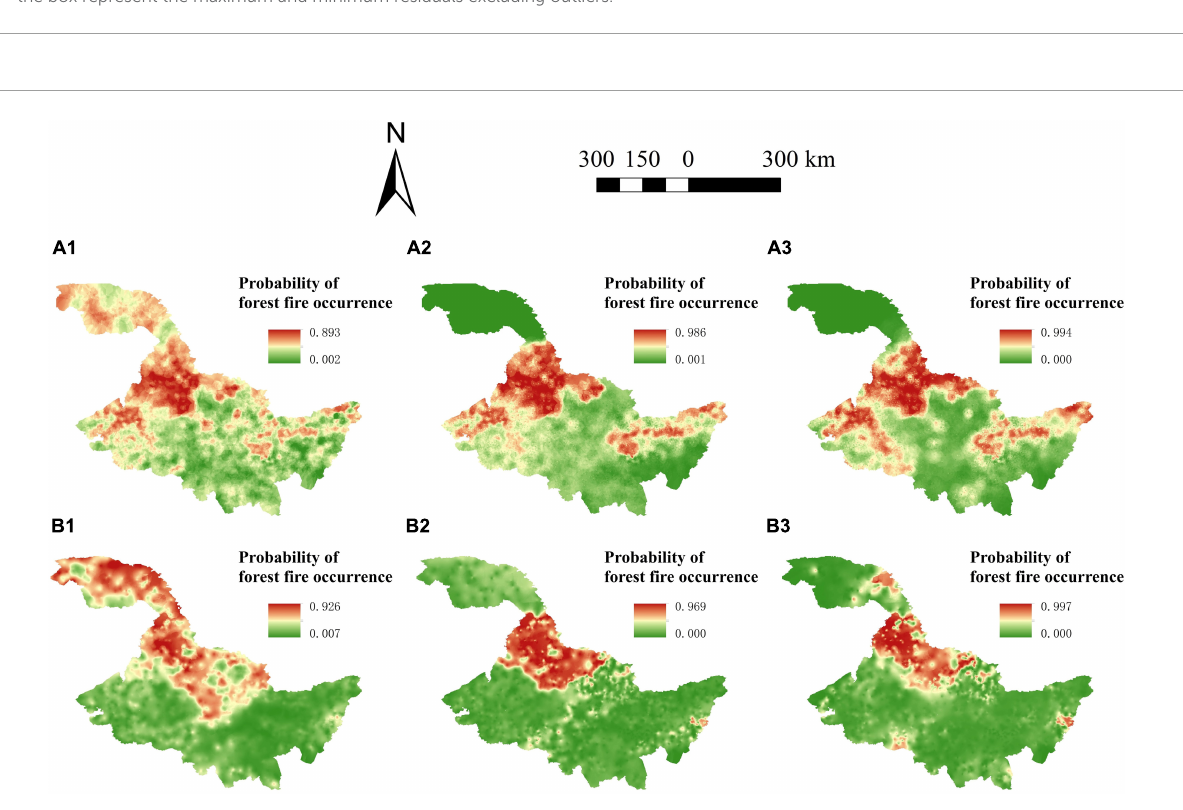
FIGURE6 Residual distributions of different models. The violin plots represent the probability densities of residual distributions of different models in spring and autumn fire prevention periods. The box plots display the distributions of residuals, the middle line of the box represents the median of residuals, the two ends of the box represent the upper and lower quartiles respectively, and the two ends of the upper and lower lines outside the box represent the maximum and minimum residuals excluding outliers.